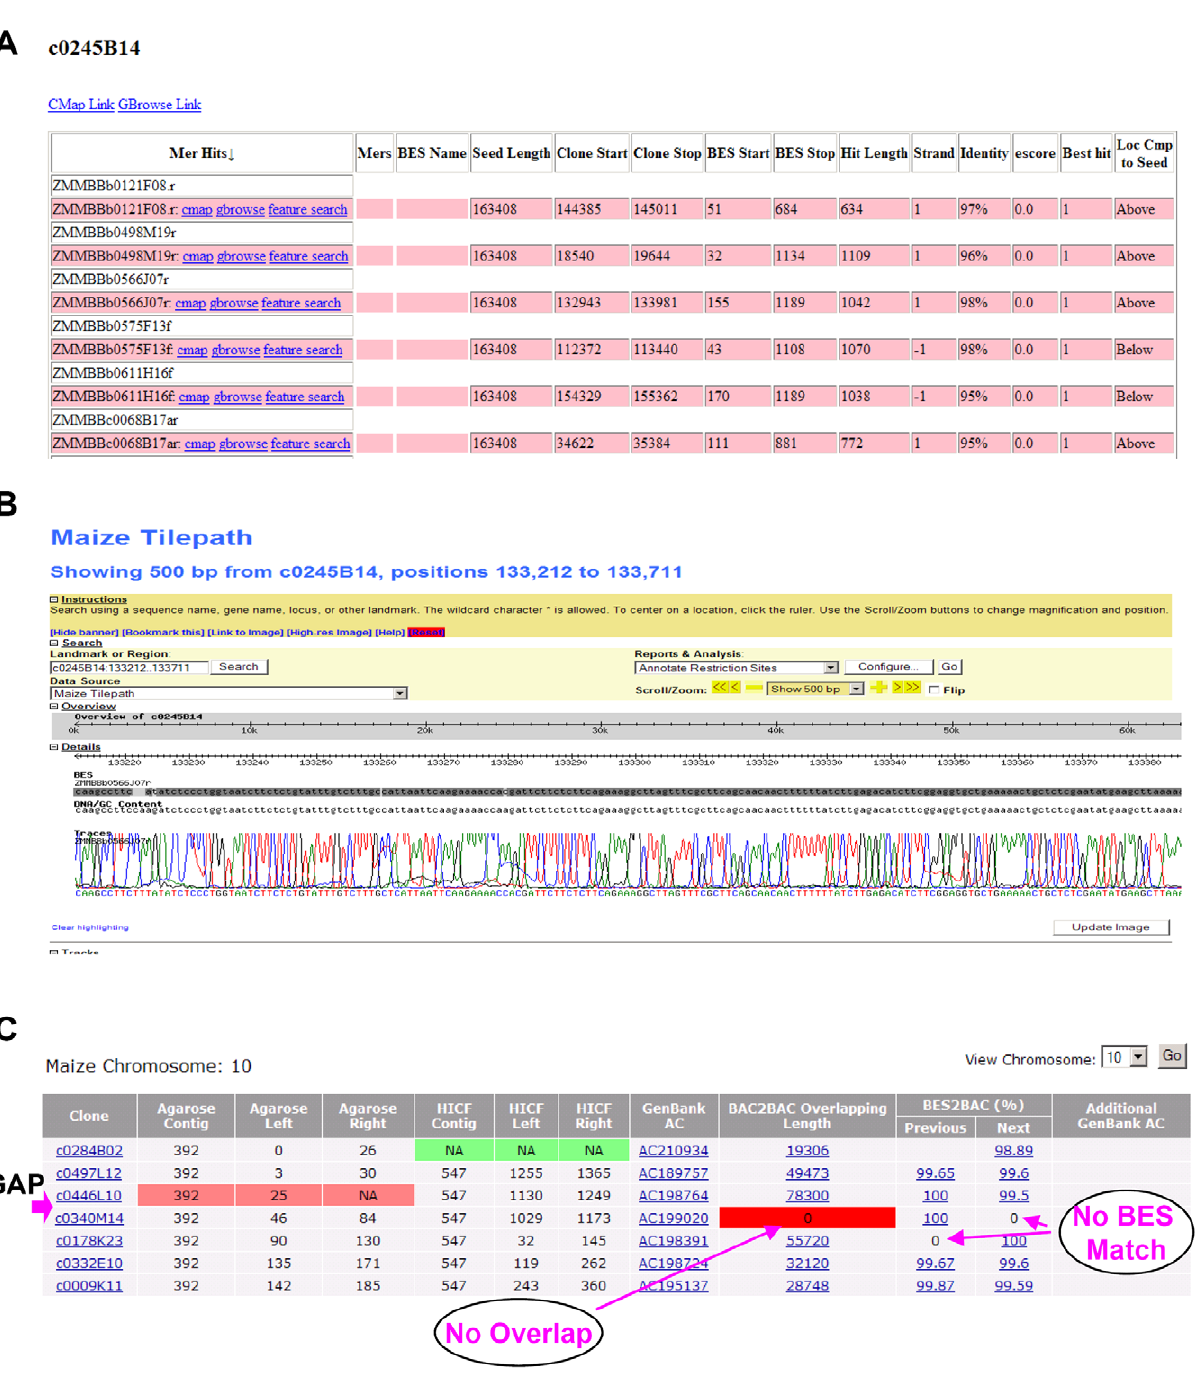
Figure 1. Sequencing pipeline for MTP clone selection and gap analysis. (A) An example of STC-based clone walking. Candidate walking clone list for seed BAC c0245B14. The list showed clones in which BES shared . 95% sequence identity with the seed BAC; (B) Gbrowse view of sequence and trace alignment of candidate clone b0566J07 to seed BAC c0245B14. (C) Gap analysis pipeline to check gaps between adjoining clones.